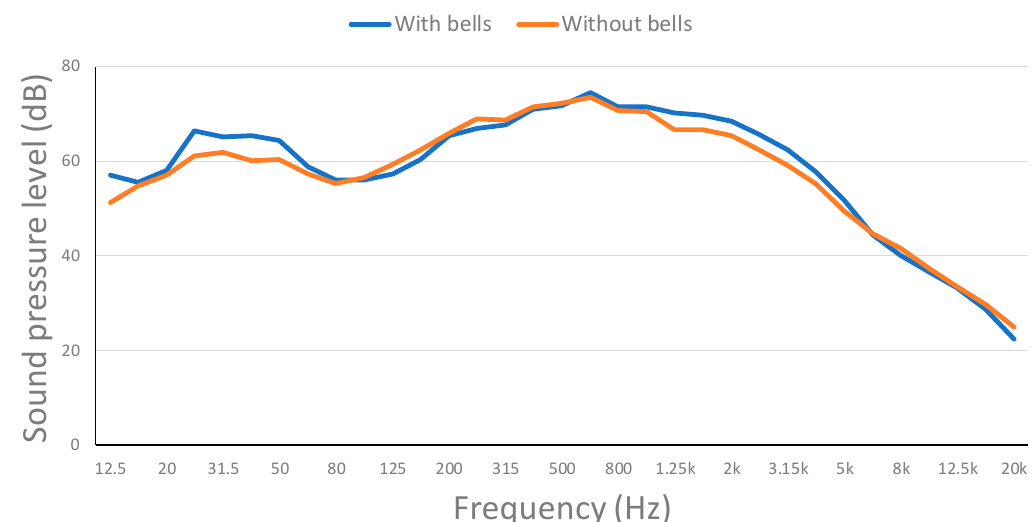
Figure 12. Evolution of the continuous sound pressure level for each frequency band in outside point 2.